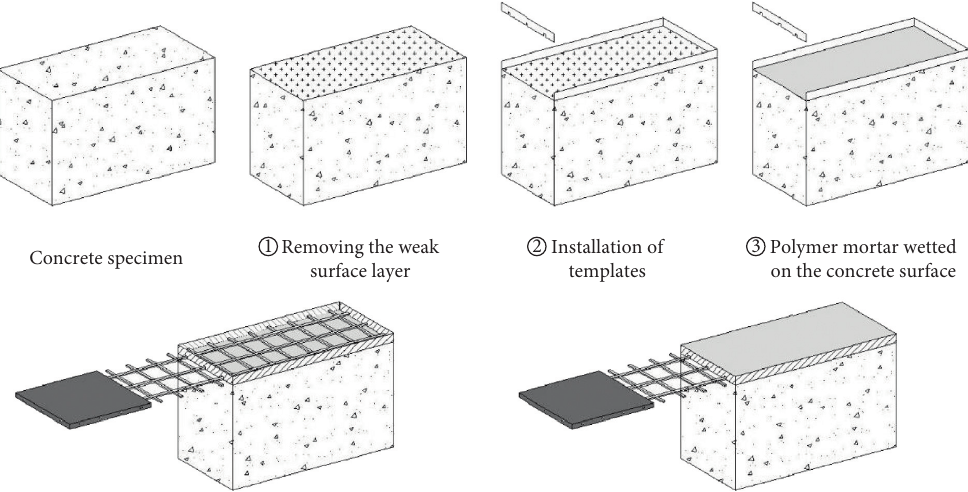
Figure 4: Preparation process of